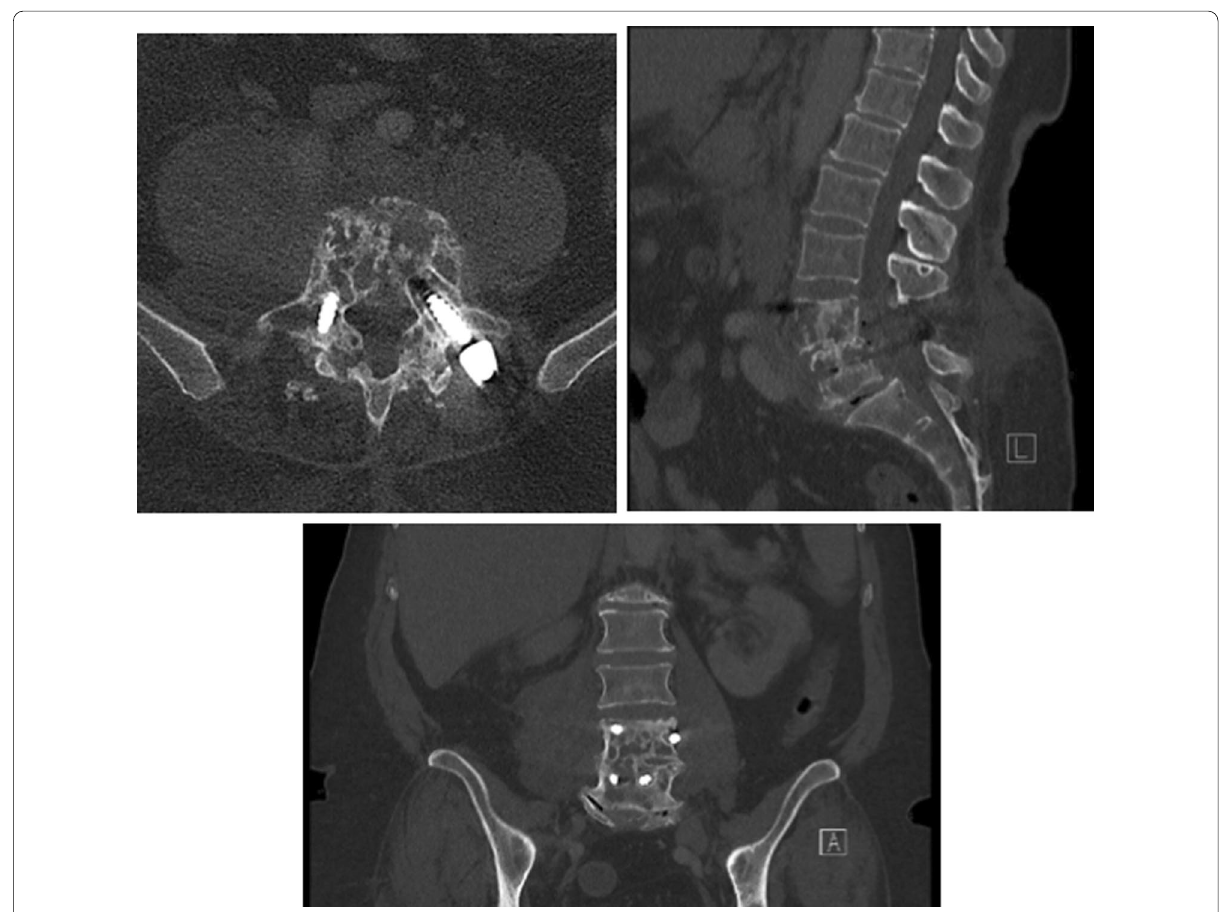
Fig. 2 Preoperative lumbo-sacral spinal CT—axial, sagittal, and coronal sections